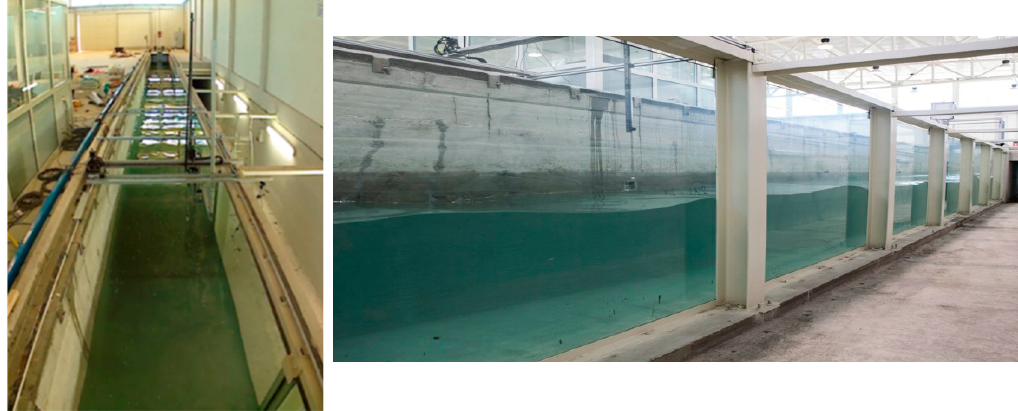
Figure 1. Top view ( left ) and side view ( right ) of 2D wave flume at EUMER lab, Unisalento.